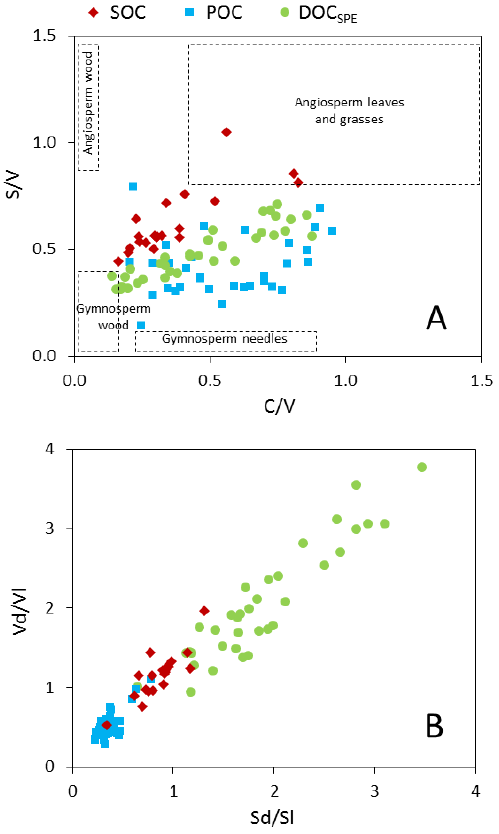
Figure 8. Lignin/phenol ratios in DOC SPE (green circles), POC (blue squares) and SOC (red diamonds). (a) Classical source plot of syringyl/vanillyl (S / V) vs. cinnamyl/vannillyl (C / V). Typical ranges for woody and non-woody tissues of both angiosperm and gymnosperm vegetation are indicated as boxes in the graph (Goñi et al., 2000). (b) The acid/aldehyde ratios of syringyl (Sd / Sl) vs. vanillyl (Vd / Vl).